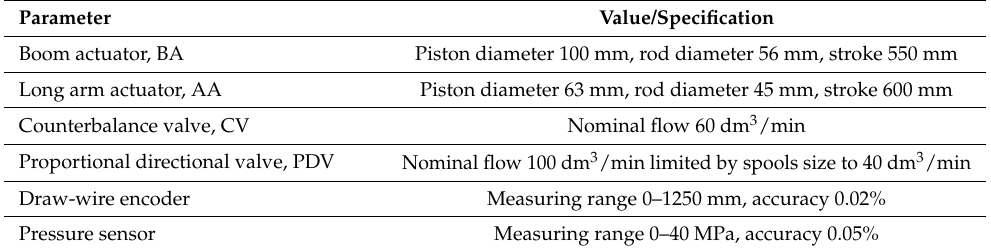
Table 1. Parameters of the main hydraulic and measuring elements.